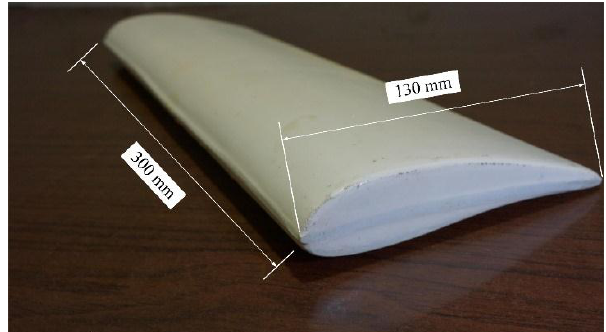
Figure 1. Wind blade test section.